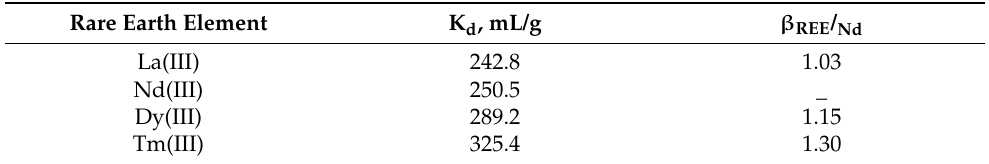
Table 4. The values of distribution coefficients (K d ) and separation factors ( β REE/Nd ) for La(III), Nd(III), Dy(III), and